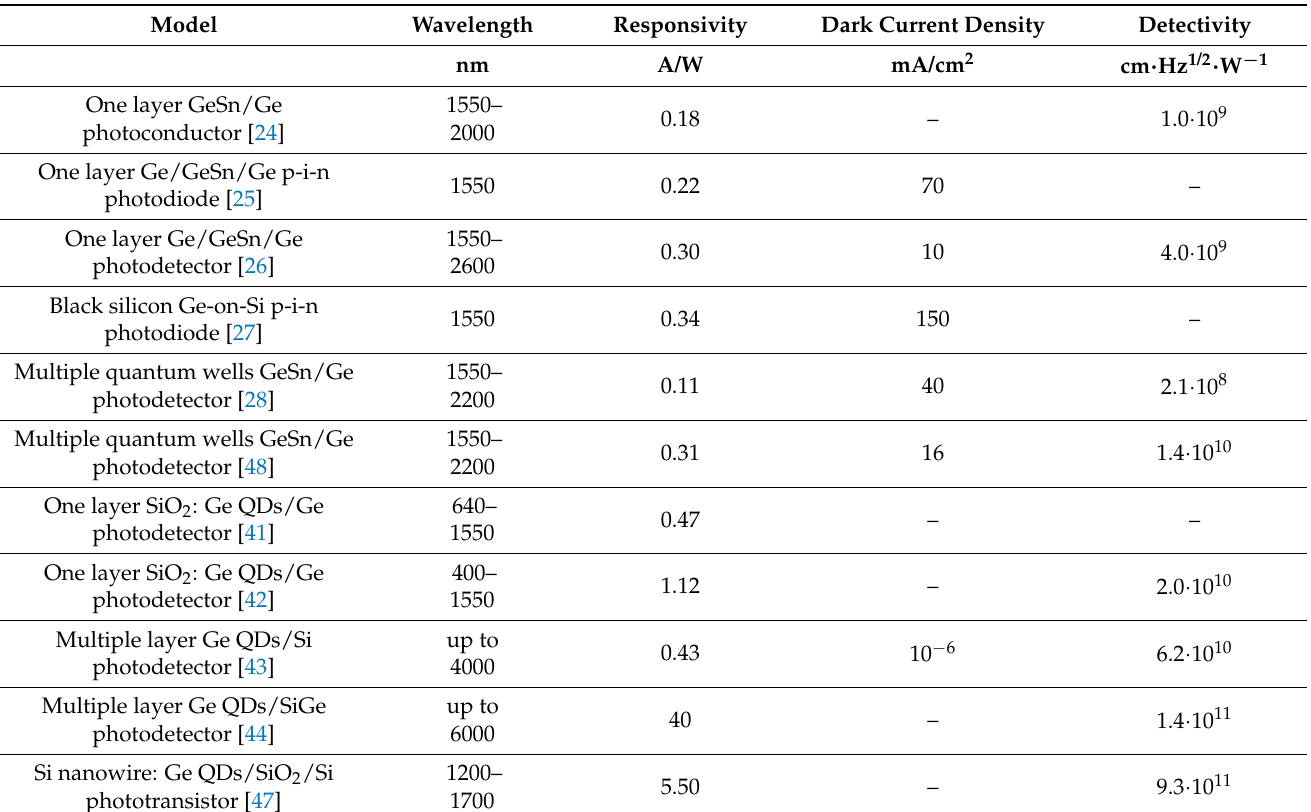
Table 1. Comparison of the performance characteristics of various types of